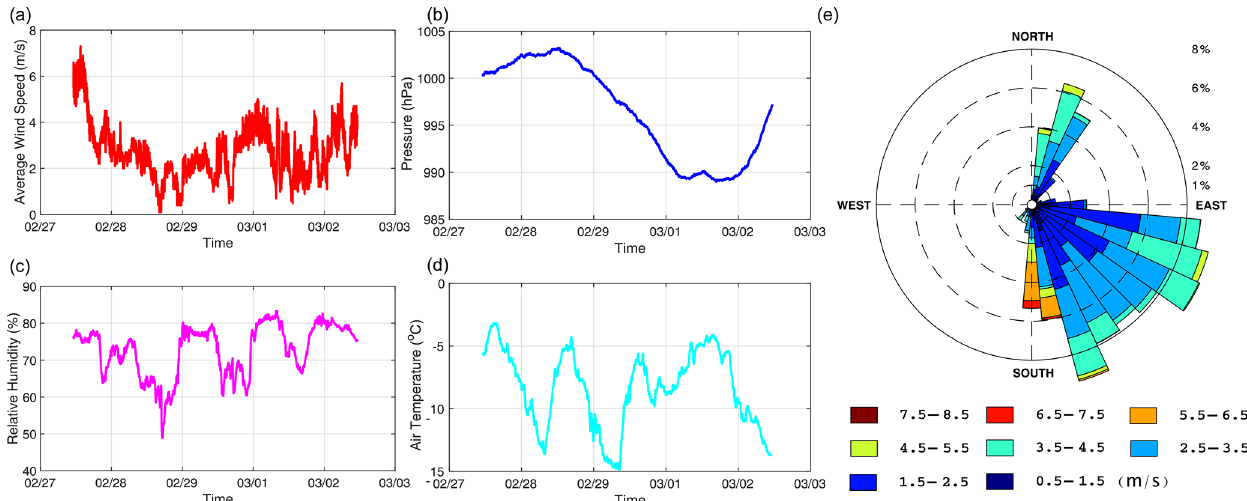
Figure 6. Automatic weather station measurements during the HAOS campaign: time series of (a) wind speed, (b) atmospheric pressure, (c) relative humidity, and (d) air temperature and (e) statistics of wind direction and speed.